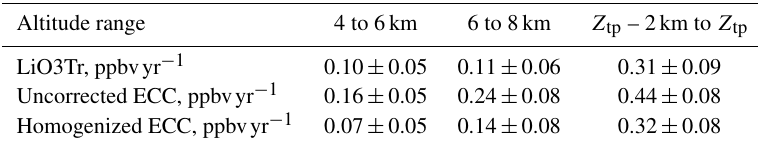
Figure 11. Interannual variation of deseasonalized O 3 mixing ratios (in ppbv) for the uncorrected ECC (green), homogenized ECC (blue) and LiO3Tr (red) for three altitude ranges in the troposphere: 4–6km (a) , 6–8km (b) and the 2km range below the 2 PVu dynamical tropopause (c) . The regression lines through all the O 3 anomalies between 1991 and 2020, O 3 trends in ppbvyr − 1 and their uncertainties with a 95% confidence are also shown in each panel. Table 1. Tropospheric trends and their confidence limits for lidar, uncorrected ECC and homogenized ECC. The last column corresponds to the 2km layer just below the altitude of the dynamical tropopause ( Z tp